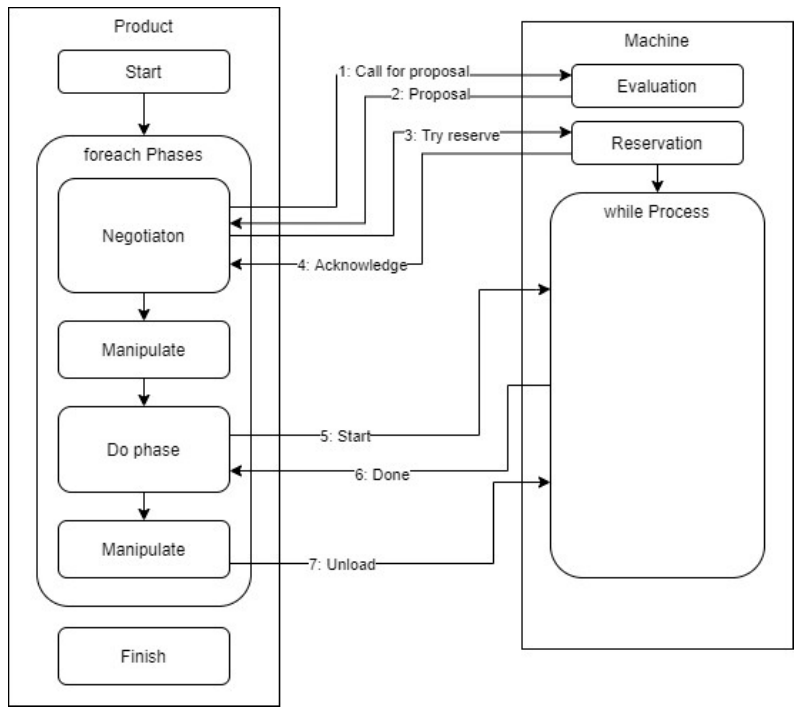
Figure 12. The architecture and flow of the discrete event simulation scenario.